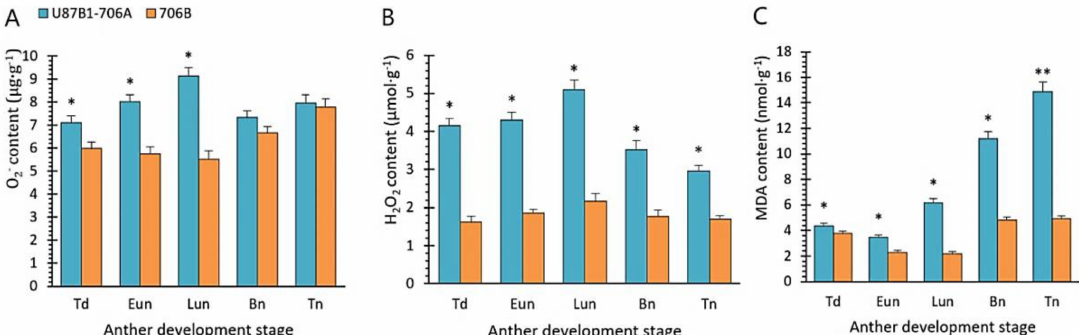
Figure 7. Accumulation of O 2– , H 2 O 2 , and MDA in the anthers of U87B1-706A and 706B during various developmental stages. Td, tetrad stage; Eun, early uninucleate stage; Lun, late uninucleate stage; Bn, binucleate stage; and Tn, trinucleate stage. ( A ) O 2– contents; ( B ) H 2 O 2 contents; ( C ) MDA contents. Students’ t test * p < 0.05, ** p < 0.01. Each value represents the mean ± SD ( n = 3).